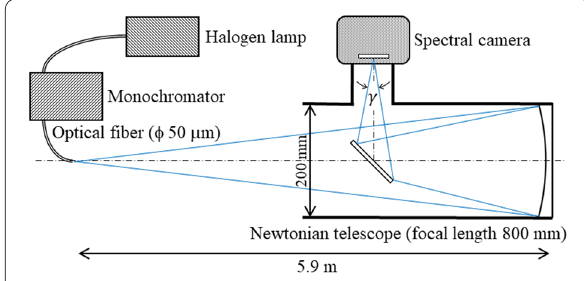
Fig. 4 Configuration of our laboratory calibration experiments. The end of the thin optical fiber is regarded as a point source. The diameter of its image on the image sensor is calculated as 7.8 µm, that is, 1.3 times the camera’s pixel size